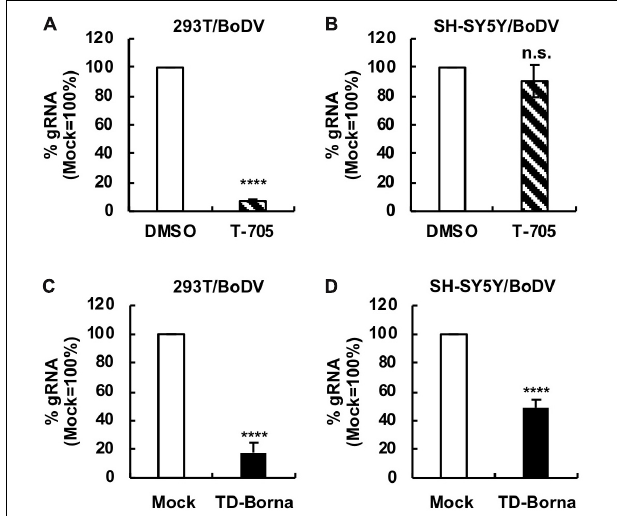
FIGURE 4 | Reduction in the BoDV-1 load by TD-Borna in neuronal and non-neuronal cell lines. (A,B) Effect of T-705 on BoDV-1 replication in 293T/BoDV (A) and SH-SY5Y/BoDV (B) cells. (C,D) Effect of TD-Borna on BoDV-1 replication in 293T/BoDV (C) and SH-SY5Y/BoDV (D) cells. The cells were treated with T-705 (A,B) or TD-Borna (C,D) for 2 days. The amount of BoDV-1 gRNA in the cells was determined by RT-qPCR analyses. Mock, the scrambled siRNA-treated control. Values are expressed as the mean ± SE of three independent experiments. ∗∗∗∗ P < 0.001 and n.s., no significance (vs. DMSO or